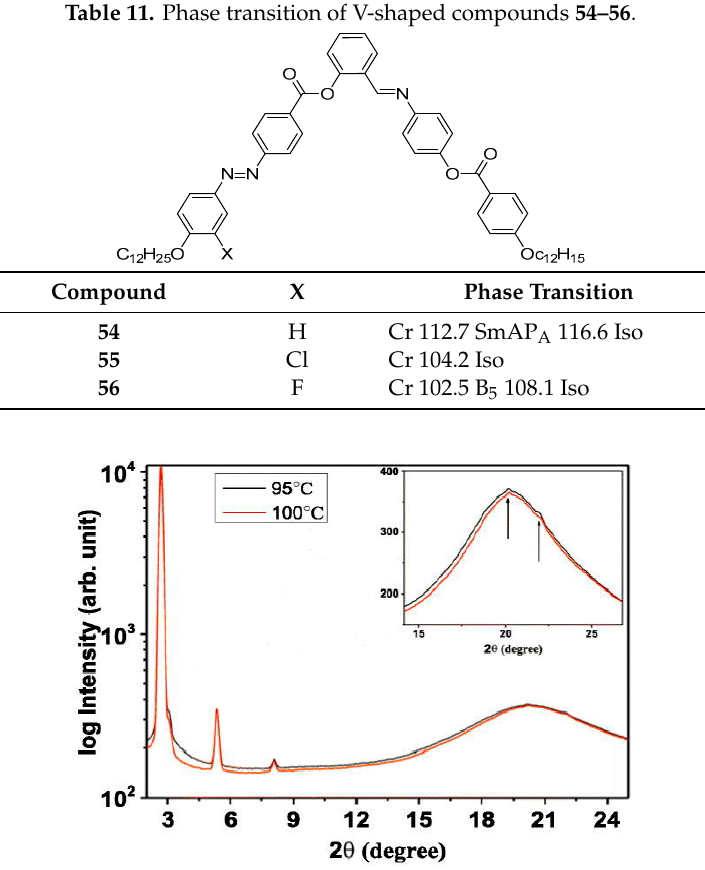
Figure 15. XRD profile of compound 56 at 95 °C and 100 °C. The inset represents the enlarged area of the wide-angle. (Reproduced with permission from ref. [111], copyright Elsevier 2018, https://doi.org/10.1016/j.molliq.2017.11.024).